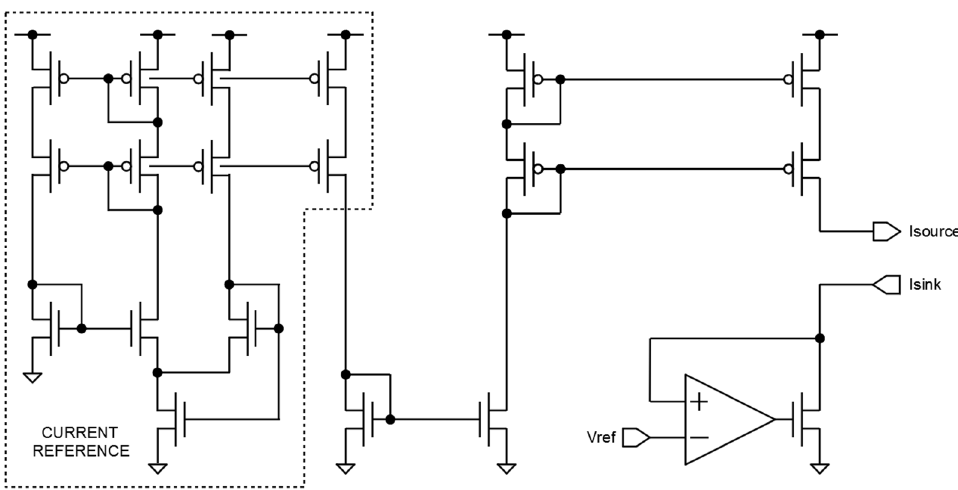
Figure 3. A simplified schematic diagram of the precision current source.